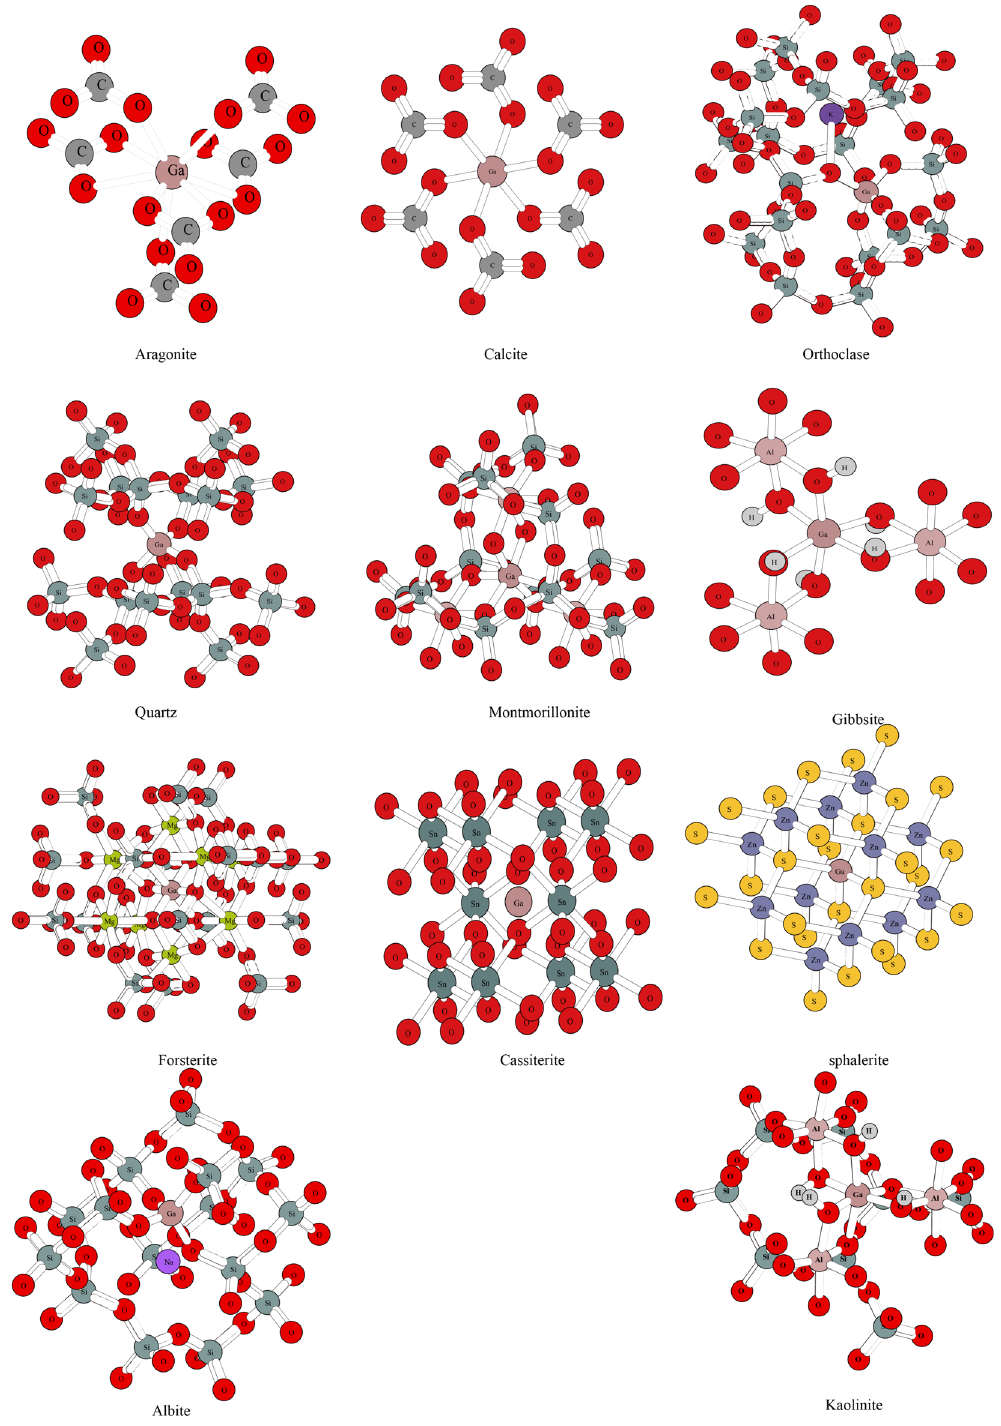
Figure 1. The cluster structures of orthoclase, albite, quartz, kaolinite, forsterite, montmorillonite, gibbsite, cassiterite, aragonite, sphalerite and calcite with Ga atoms in center. The coordination number of central Ga atoms for aragonite is nine, for kaolinite, forsterite, montmorillonite, gibbsite, cassiterite and calcite are six, for albite, orthoclase, sphalerite and quartz are